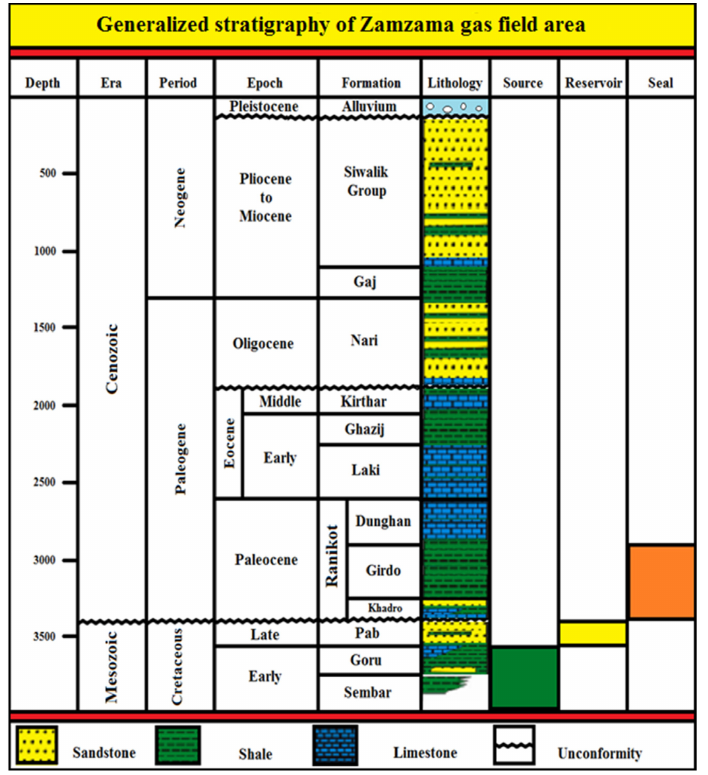
Figure 2. Generalized lithostratigraphy of the Lower Indus Basin [34].